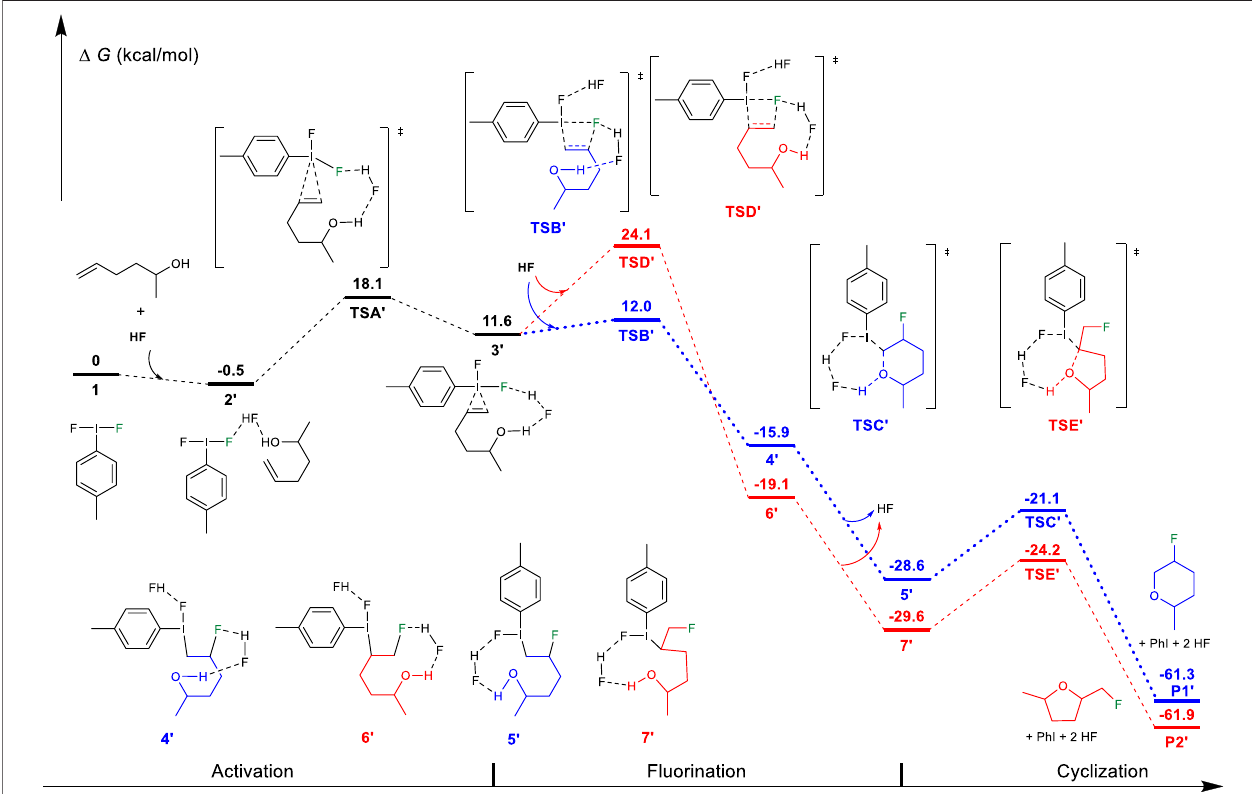
FIGURE2| Free-energypro fi les for the fl uorocyclization ofunsaturated alcohol via the “ fl uorination fi rstand cyclization later ” mechanism. Thepreferred pathway is shown in blue.